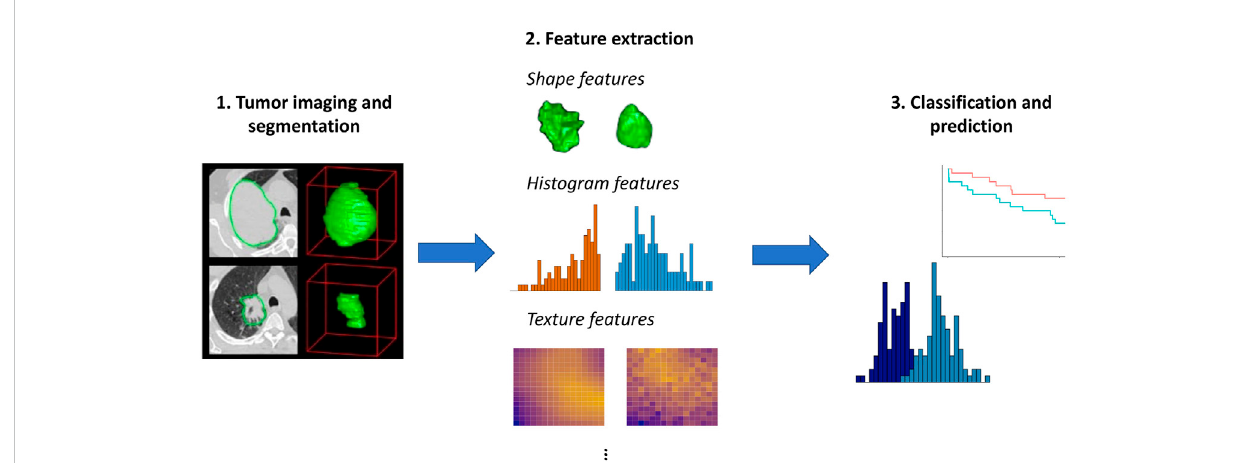
FIGURE 1 Overview of radiomics. Here, we use images from Aerts et al. (2014) to illustrate the initial step of tumor imaging and segmentation. Quantitative features can then be extracted that summarize the tumor boundary (shape features), the distribution of the pixel intensity values within the tumor (histogramfeatures),andaspectsofthespatial relationsamongpixelswithdiffering intensities (texturefeatures).Moreadvancedfeaturessuchasmodel- or tree-based summaries may also be computed. These features can then be used as input to approaches aimed at prediction of survival outcomes or classi fi cation methods such as mixture models, as illustrated generically in Step